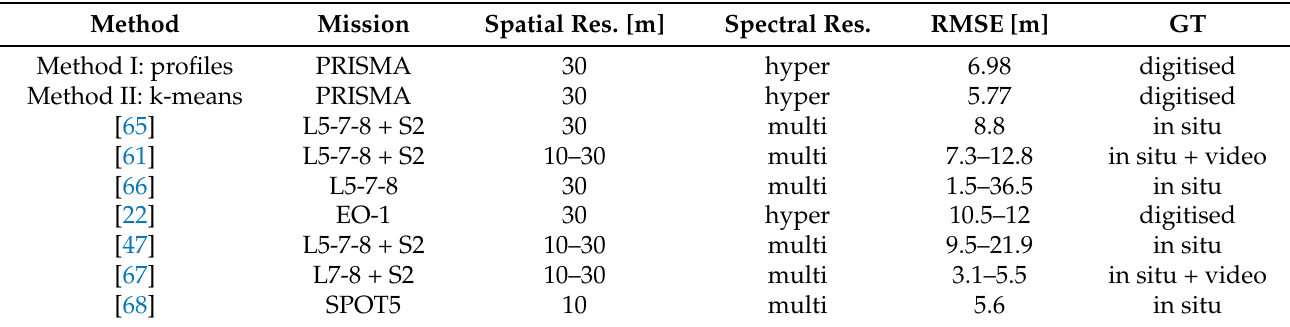
Table 9. Summary of SDS retrieval literature. In the table are indicated: the mission used to develop the methodology, the image satellite spectral resolution [m] and the spectral resolution, the reported RMSE [m], and the Ground Truth used to validate the